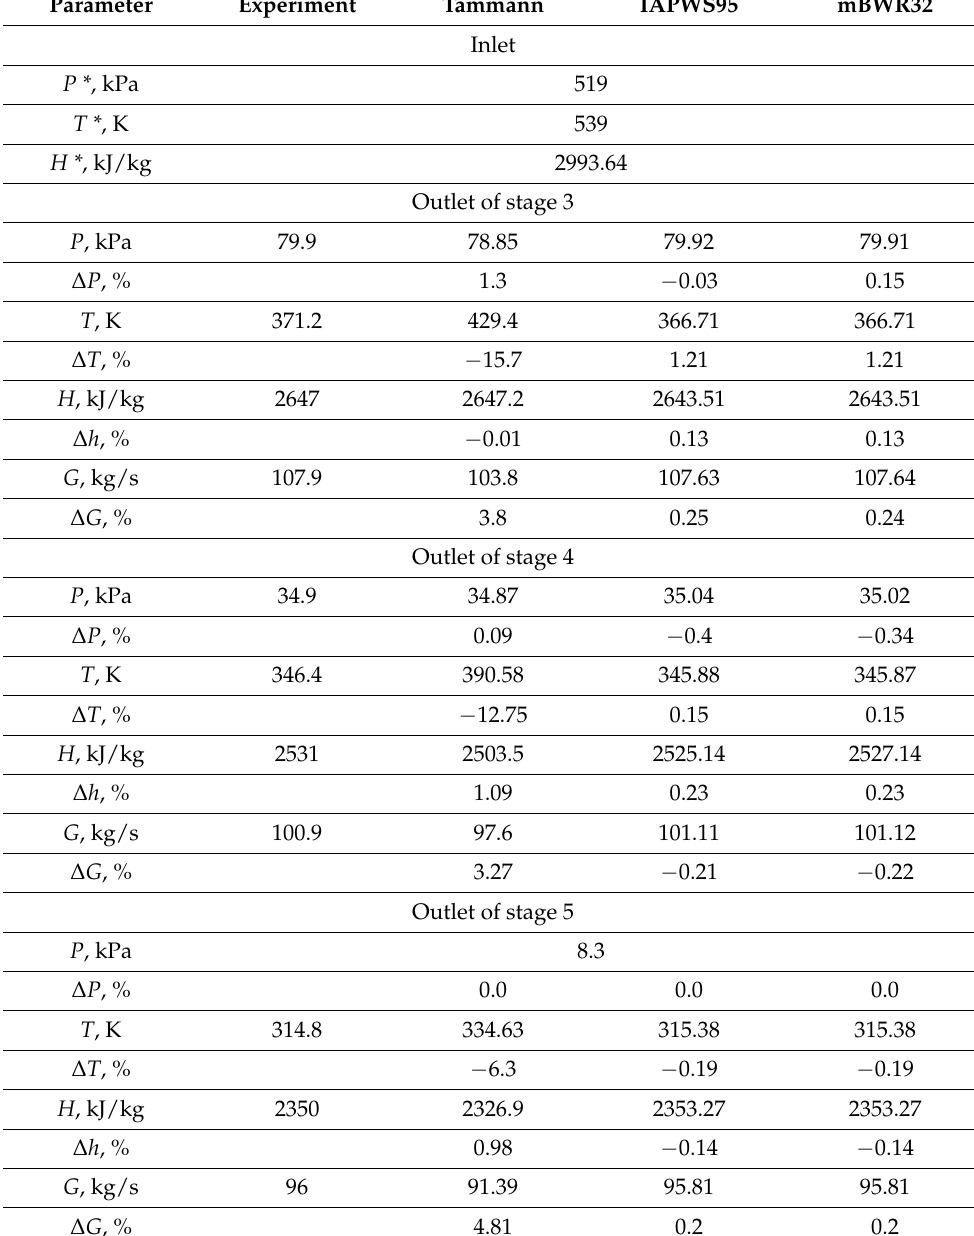
Table 3. Comparison of experimental and calculated pressures, temperatures, enthalpies, and flow rates at the outlets from stages 3, 4, and